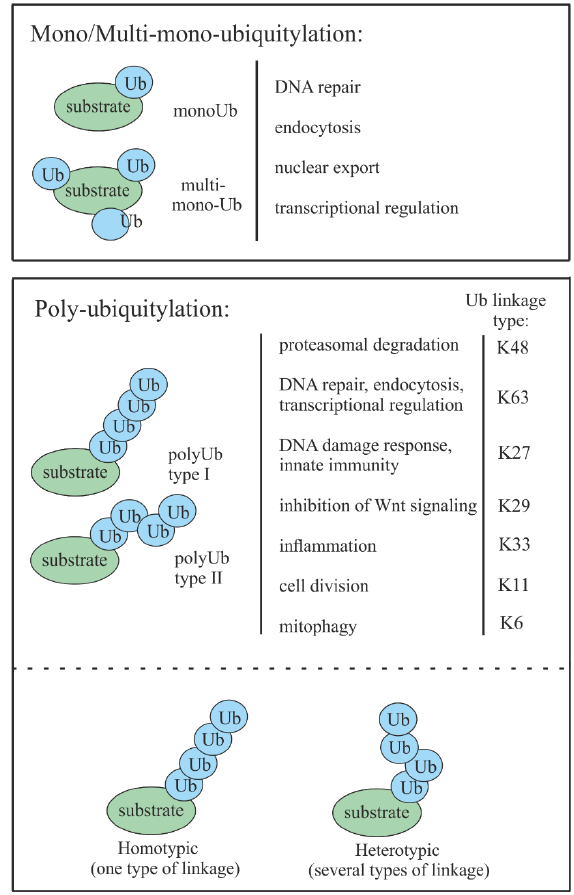
Figure 2. Schematic representation of different types of protein substrate Ub modifications together with their roles in cell